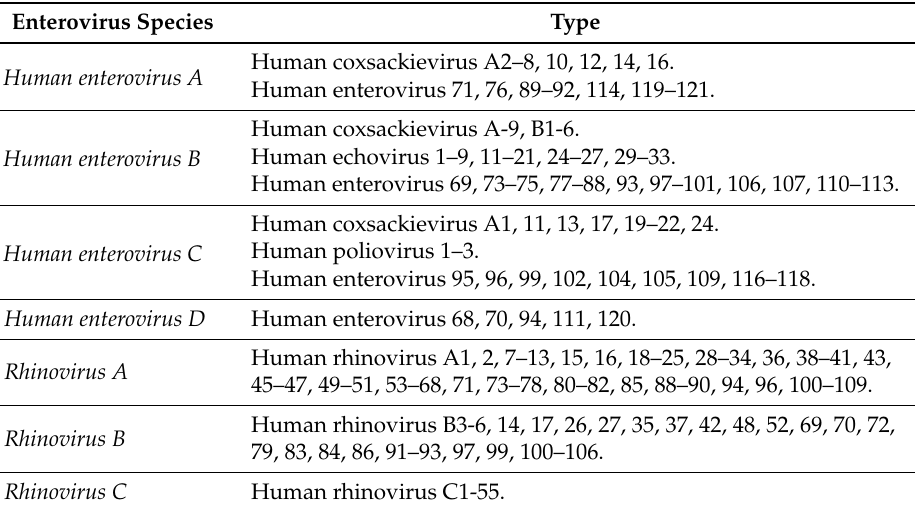
Table 1. Classification of human enteroviruses